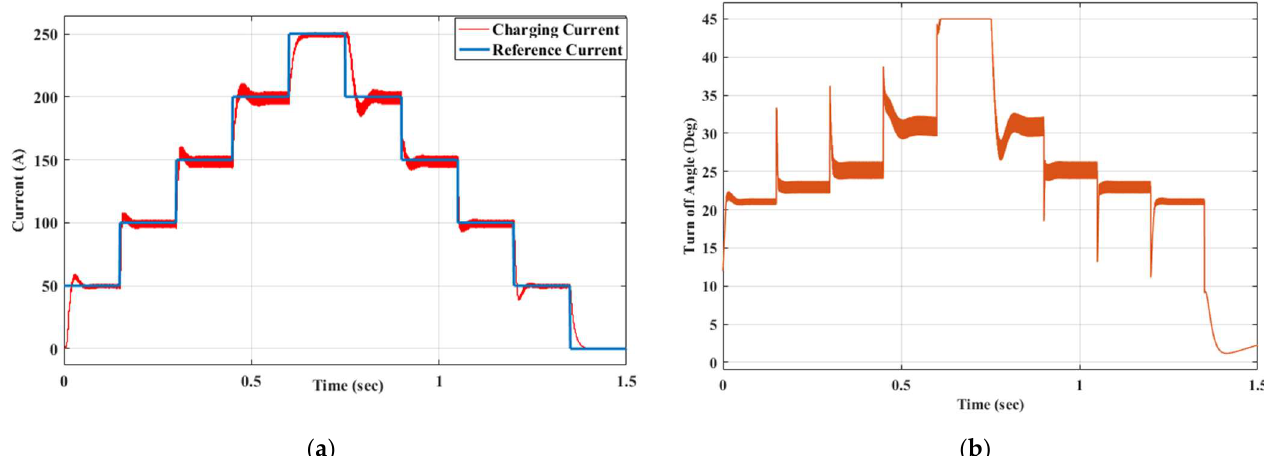
Figure 14. Turn-off angle control on constant (charging) current response (V battery = 250 V, θ on = 0°), ( a ) the constant current at different reference values and ( b ) the corresponding turn-off angle.